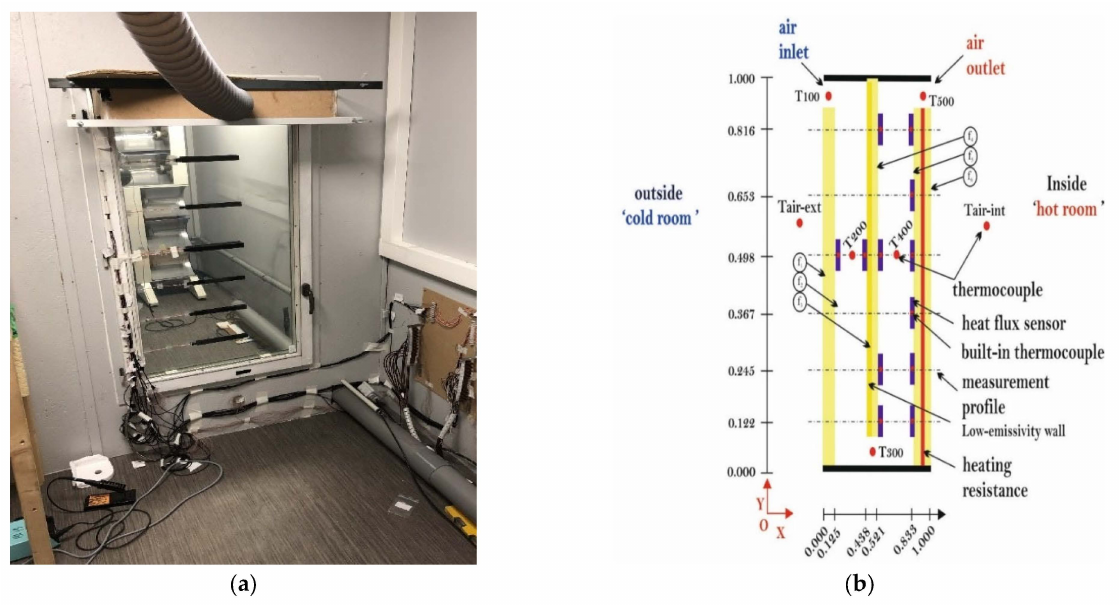
Figure 3. The heating window: ( a ) experimental apparatus; ( b ) schematic diagram of